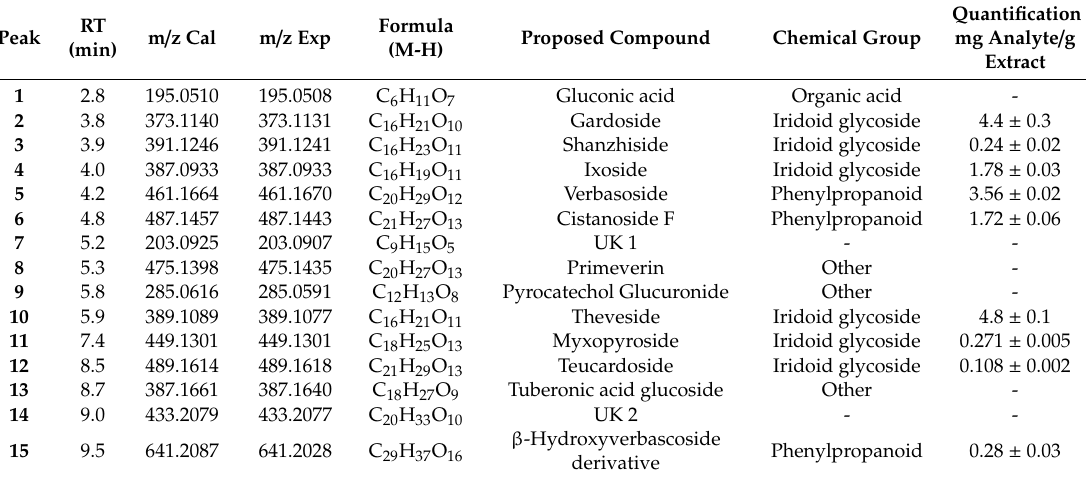
Table 2. Qualitative and quantitative results of L. citriodora extract.